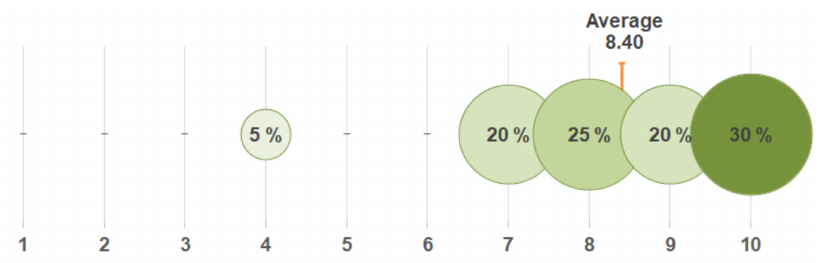
Figure 9. Distribution of the answers concerning the potential of wireless and conductive charging (1 = wireless and 10 =